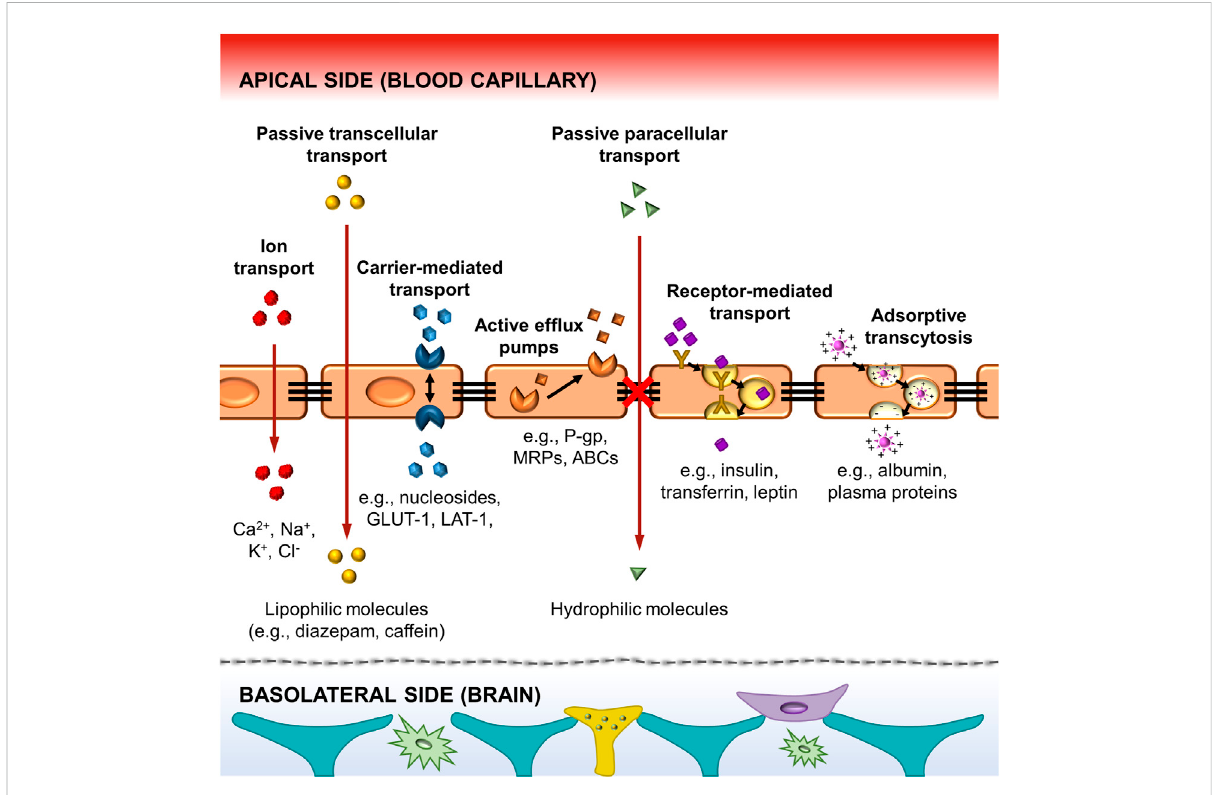
FIGURE 2 Schematic illustration of the principal pathways for molecular traf fi c across the BBB. It includes the active transport by the carriers-mediated, the ef fl ux pumps, the receptors-mediated and the adsorptive transcytosis. The passive transport includes the transcellular diffusion of lipophilic molecules across the BBB, and the paracellular transport of hydrophilic molecules. The tight junctions between the endothelial cells prevent several molecules from easily crossing theBBB. Finally,ion transport is achieved byion channels.Somerepresentative molecular substances following each type of mechanism are also presented in the